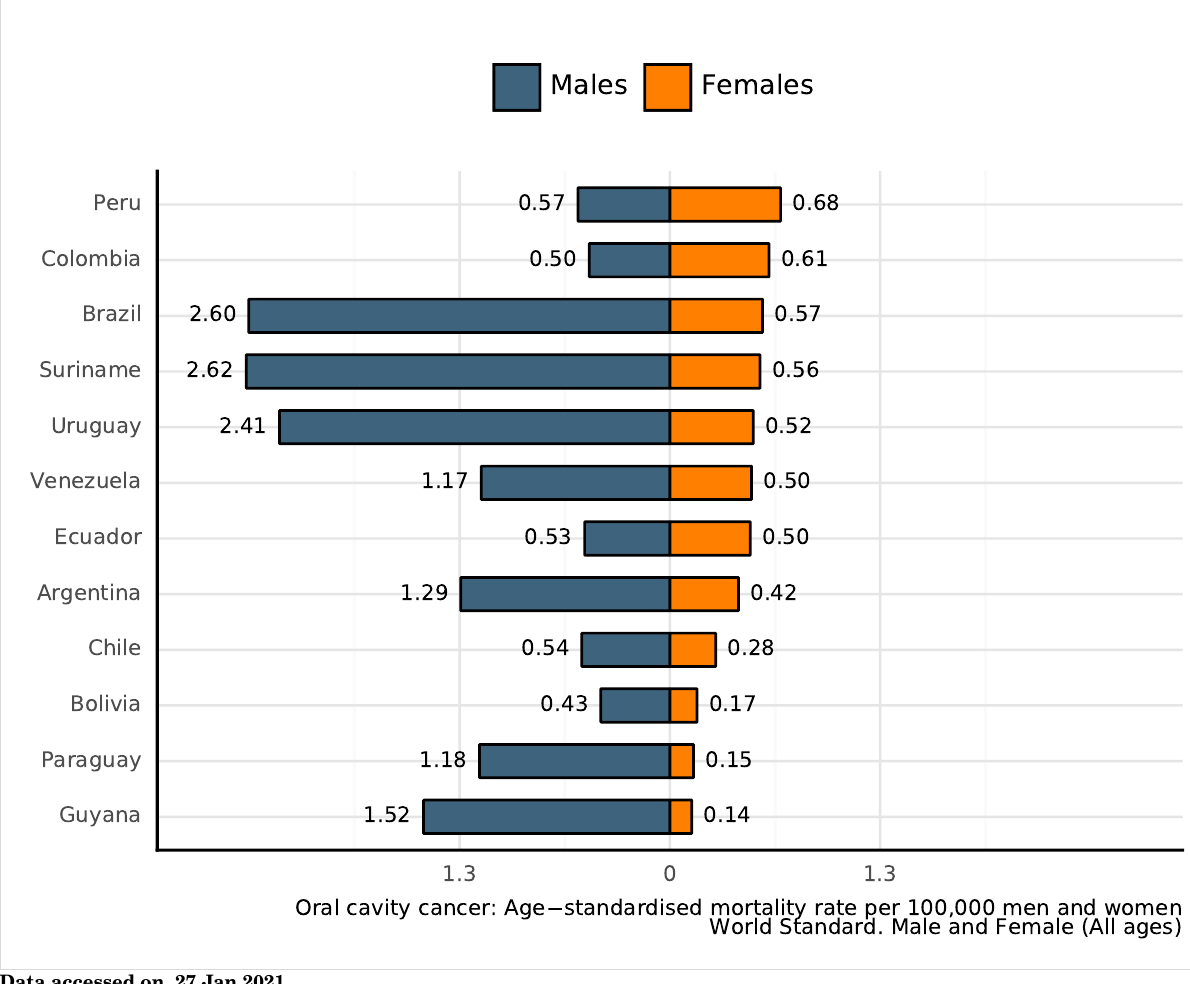
Figure 127: Age-standardised mortality rates of oral cavity cancer of Peru (estimates for 2020)